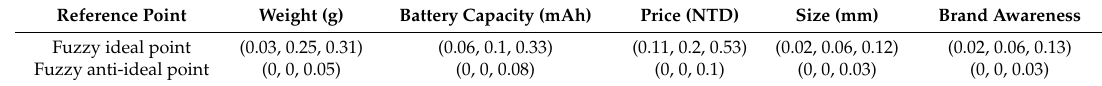
Table 6. The fuzzy ideal point and the fuzzy anti-ideal point.